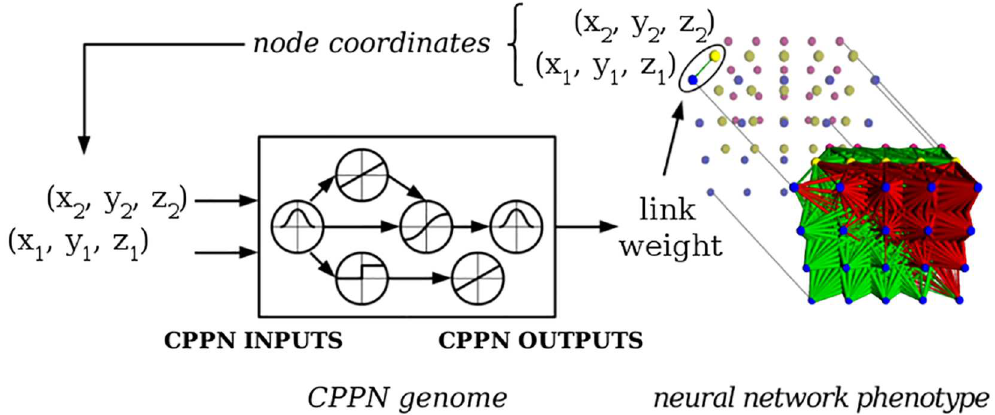
Fig 2. HyperNEATgeneratesan ANN phenotype. Adapted from [24]. The coordinatesof two nodesin the ANN phenotype are input to the CPPN, which outputs the link weight betweennodes. The process is repeated for all links allowedin the phenotype. Red links are inhibitory,green links are excitatory, and link weight magnitude is indicated by the thickness of the link.